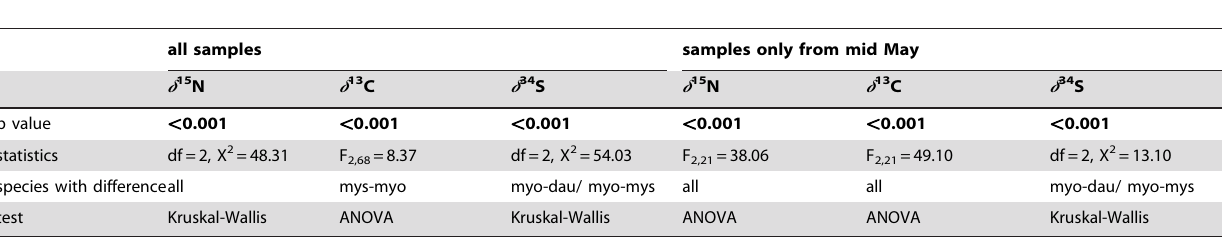
Table 1. Results of the ANOVAs and post-hoc tests or Kruskal-Wallis for the comparison of the stable isotope values between the species, using i) all the samples and ii) the samples collected in the middle of May